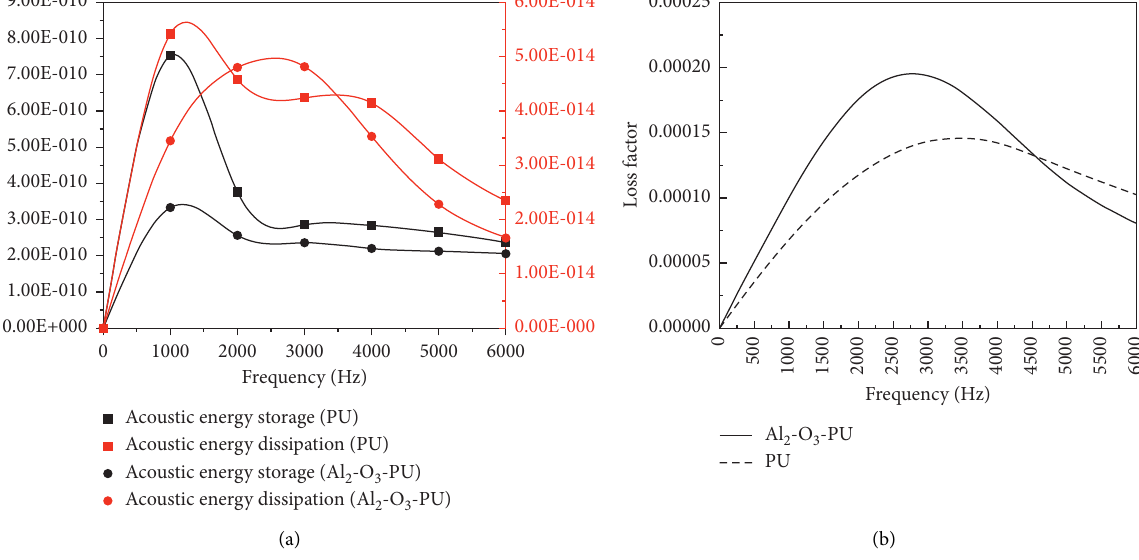
2 O 3 -PU foam. (b) Loss factor for single-hole